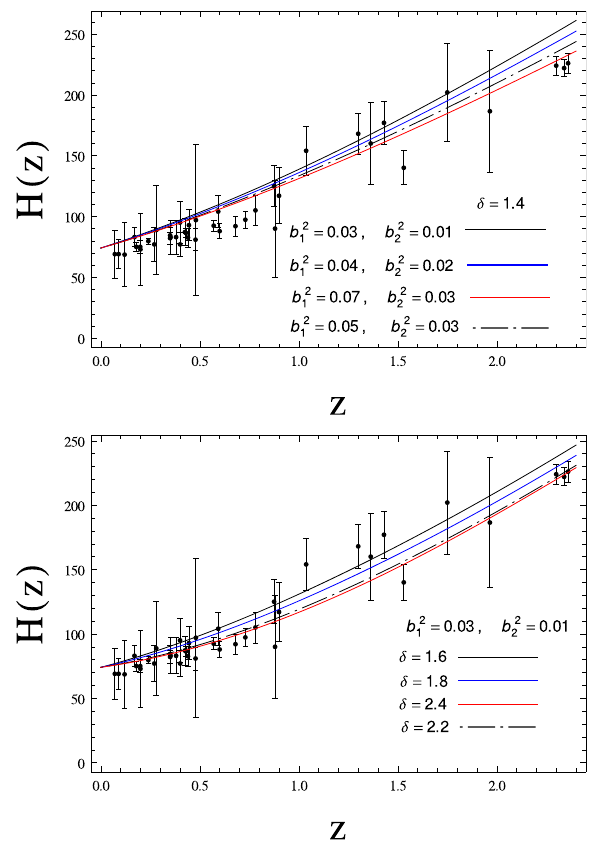
Fig. 5 The evolution of H ( z ) , as given in Eq. (18), is shown by con- = 0 . 73 and different values of the parameters ( δ , b 2 sidering (cid:5) 0 D as indicated in each panel. In this plot, the black dots correspond to the H ( z ) data consisting 41 data points with 1 σ error bars [91,92]. Also, the latest measurement of H 0 is taken from [93]